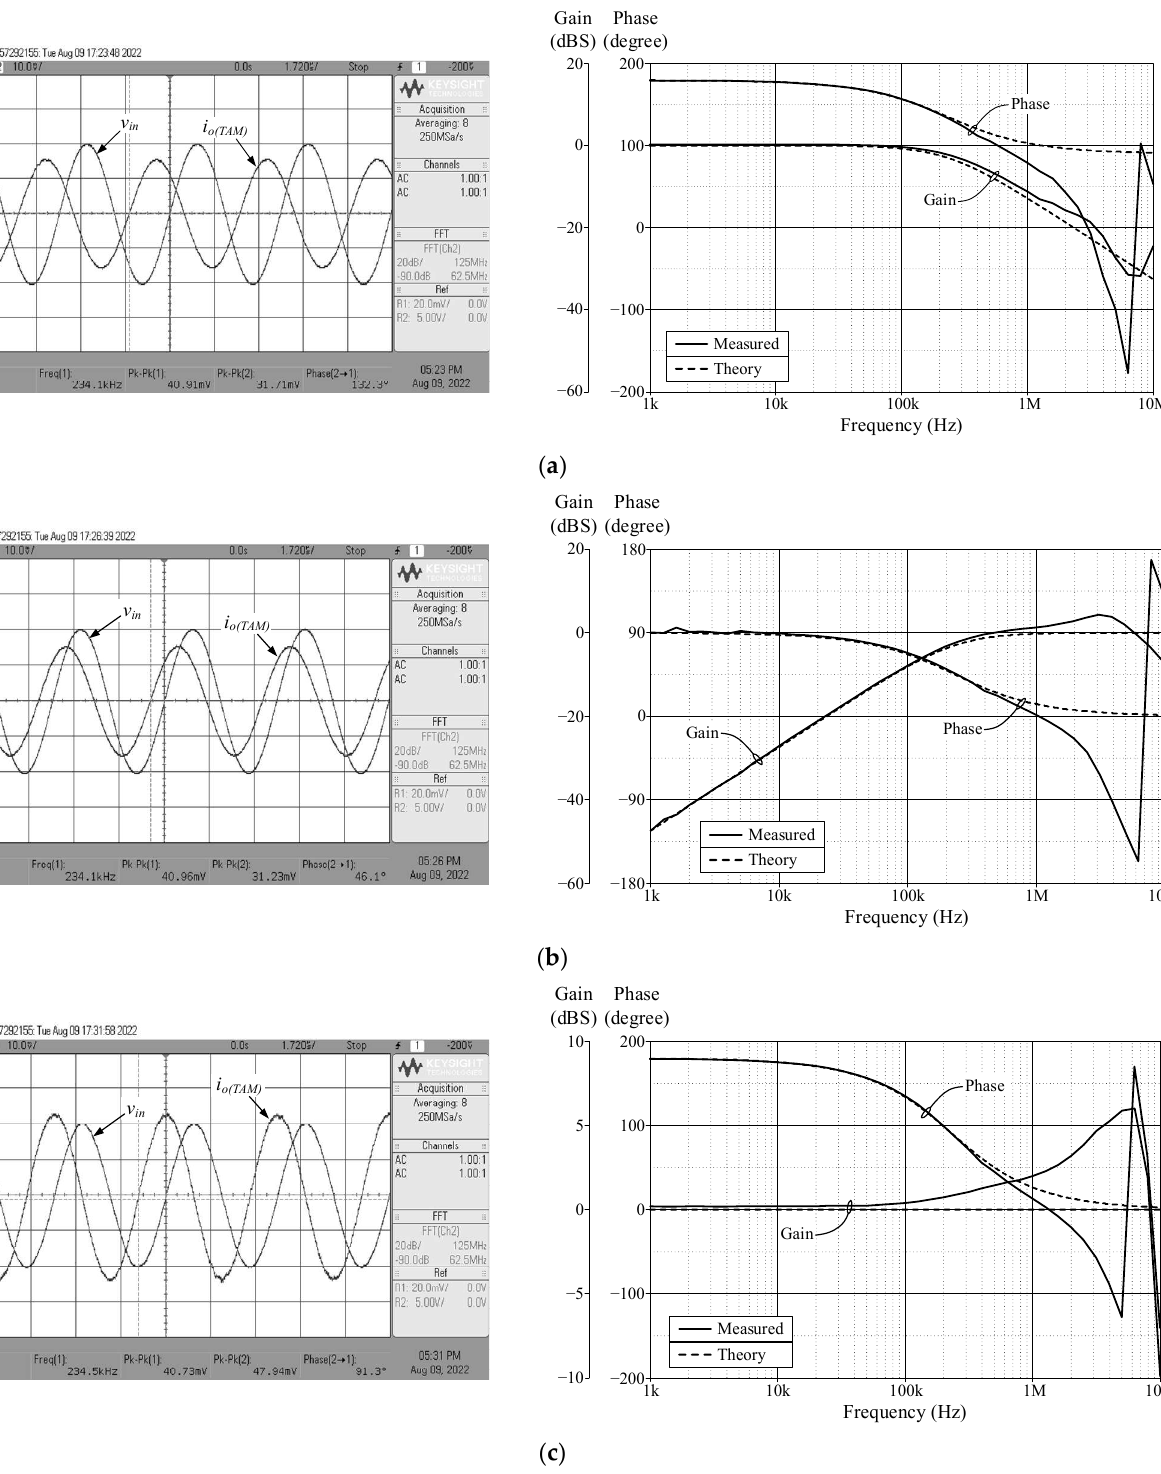
Figure 14. Measured time and frequency responses of the proposed TAM filter: ( a ) LP; ( b ) HP; and ( c ) AP.